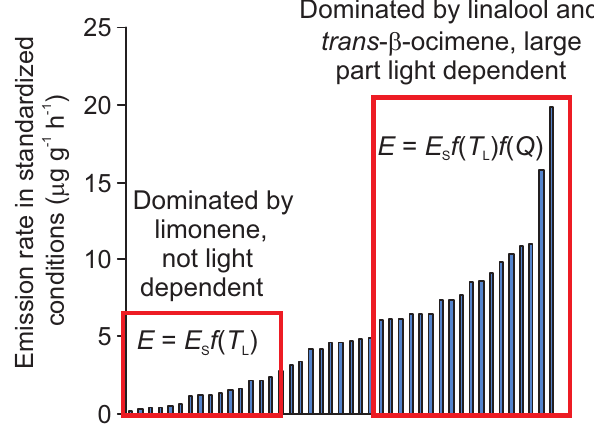
Fig. 7. Estimates of monoterpene emission rate under standardized conditions (leaf temperature, T L =30 ◦ C, incident quantum flux den- sity, Q =1000µmolm − 2 s − 1 ), “the emission potential” ( E S ) from the foliage of Mediterranean evergreen conifer Pinus pinea (data of Corchnoy et al., 1992; Kesselmeier et al., 1997; Owen et al., 1997, 1998, 2001, 2002; Owen and Hewitt, 2000; Pio et al., 1993; Sabill´on and Cremades, 2001; Seufert et al., 1997; Staudt et al., 1997, 2000; Street et al., 1997; Winer et al., 1983). The estimates of E S ( n =43) were ranked from the smallest to the largest. In stud- ies demonstrating low E S , the emissions were typically dominated by the monoterpene limonene and were not light-dependent (con- stitutive emissions). In studies demonstrating large emissions, the emissions were typically dominated by the monoterpenes linalool and trans - β -ocimene that are considered as typical stress-induced monoterpenes. These emissions were both light- and temperature dependent (e.g., Niinemets et al., 2002b; Staudt et al., 1997). Thus, conceptually, the constitutive emissions can be predicted by Eq. (5), induced emissions by Eqs. (2) and (3), and total emissions by Eq. (12). However, due to non-specific storage of induced monoter- penes (Noe et al., 2006), a dynamic model is needed to describe these emissions (Eqs.